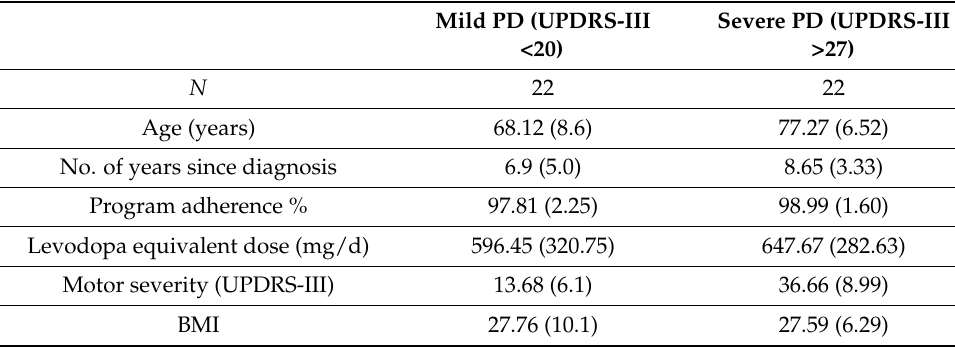
Table 1. Demographic